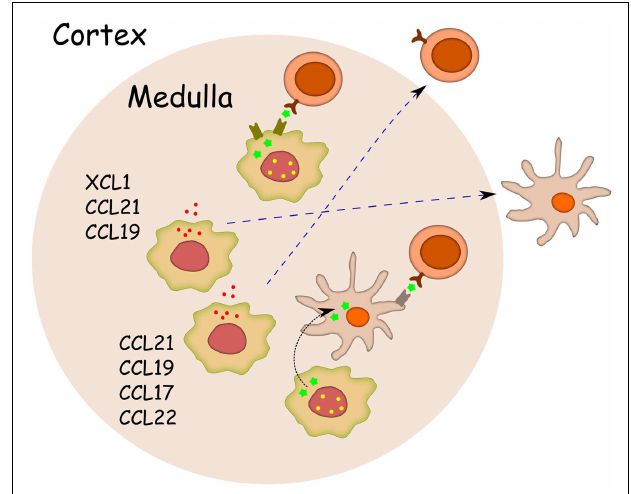
FIGURE 3 |Aire regulates chemokines required for proper localization of thymocytes and dendritic cells . For effective direct antigen presentation (shown as green pentagons) from mTEC to thymocyte, the positively selected single-positive thymocytes need to migrate from cortex to medulla. For effective indirect antigen presentation both, the positively selected thymocytes and the DCs, need to migrate to medulla. Only the key chemokines (shown as red particles) known to mediate the migration of single-positive thymocytes or DCs, and also known to be regulated by Aire (shown as yellow dots) are